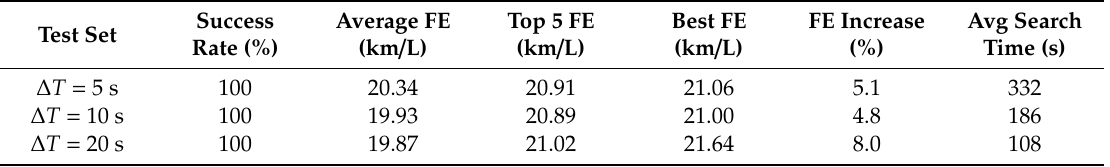
Figure 10. Fuel economy changes during di ff erent training iterations. The points in the graph are the average of 50 di ff erent policy search rounds in the set. Table 4. Policy search round